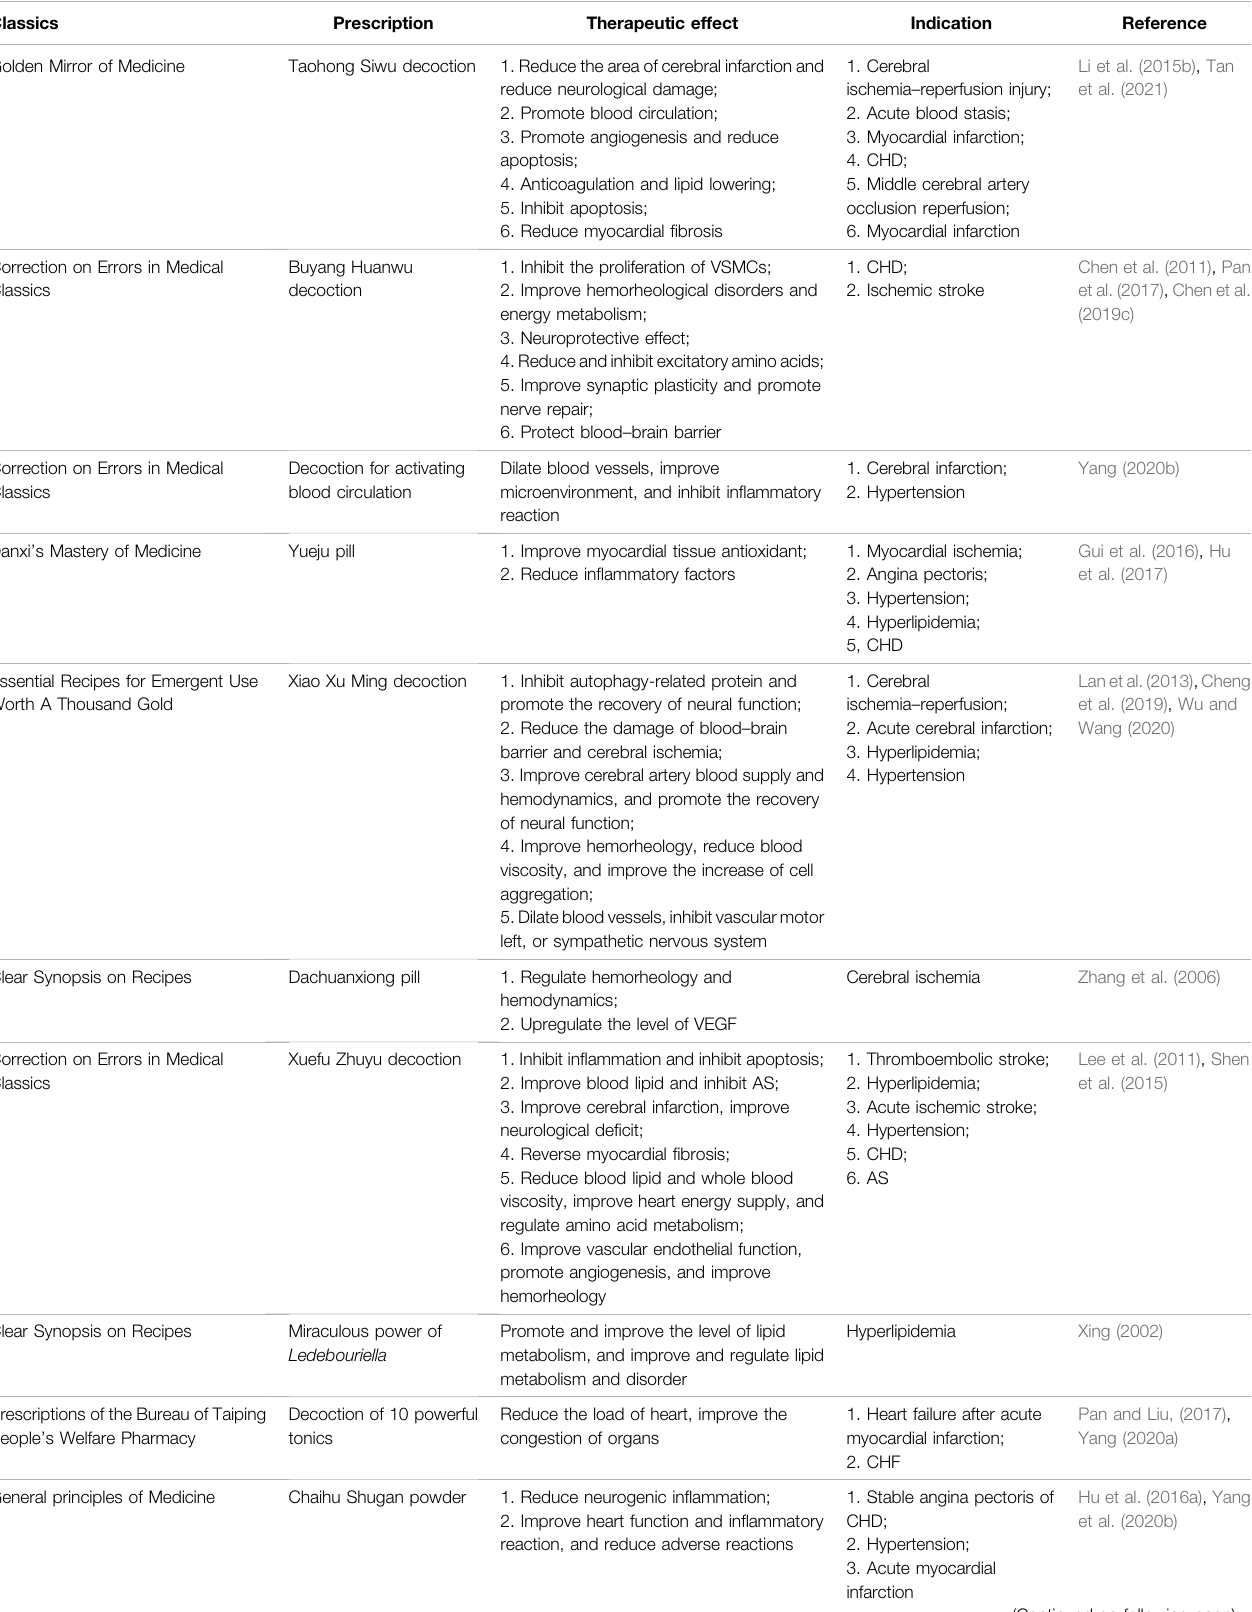
TABLE 2 | Application of classical prescription containing Ligusticum chuanxiong Hort. in